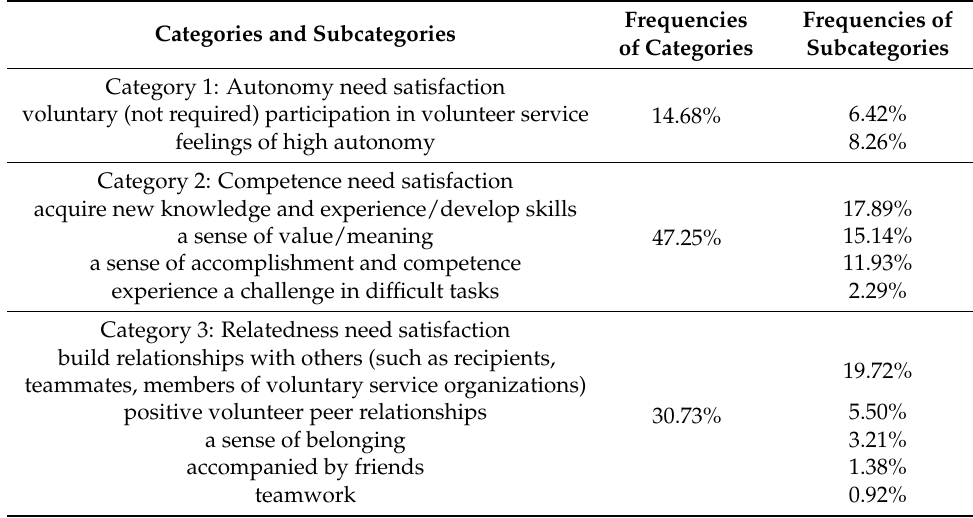
Table 3. Codes and frequencies of volunteers’